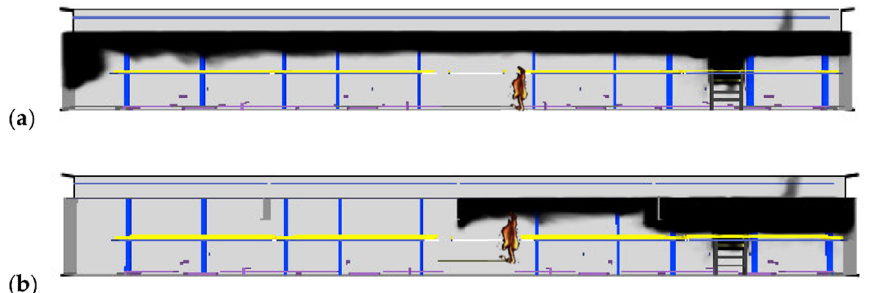
Figure 10. Smoke in a 180 m long turbine house and a height of 30 m. ( a ) No smoke curtains, ( b ) 8- m high curtains from the